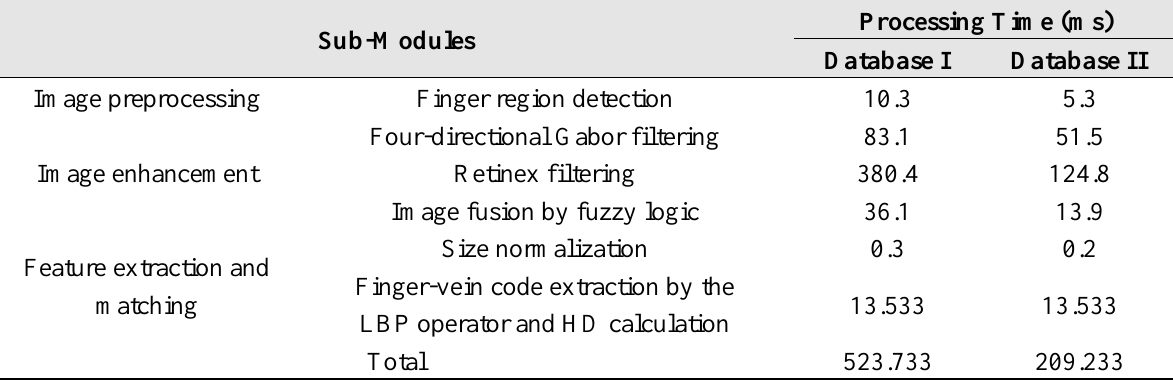
Table 8. Processing time for each sub-module of the proposed method per